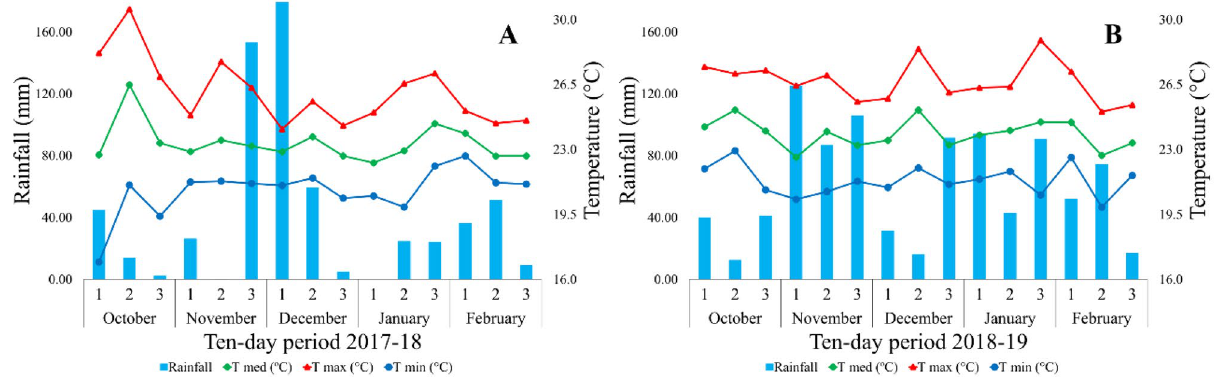
Figure 3. Mean rainfall (mm), maximum, minimum, and mean temperature (°C) recorded at 10-day intervals during the corn cultivation in 2018 ( A ) and 2019 ( B ). Chapadão do Céu. The software used to create this figure was Microsoft Excel (v1804, https:// www. micro soft. com).